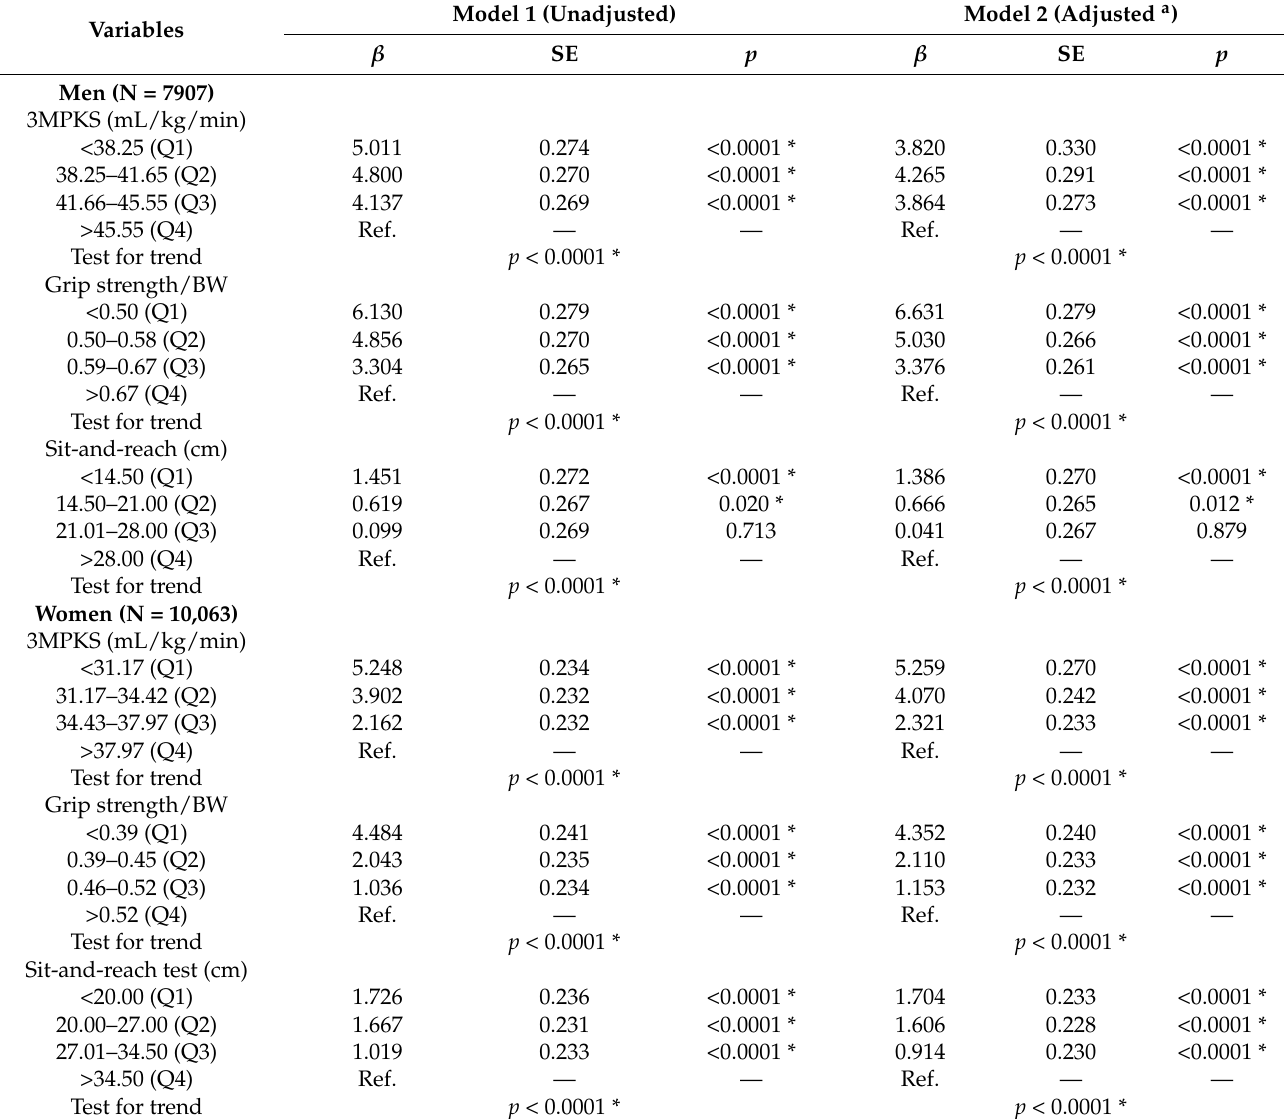
Table 4. Regression coefficients for predicting the waist circumference using different quartiles of health-related physical fitness